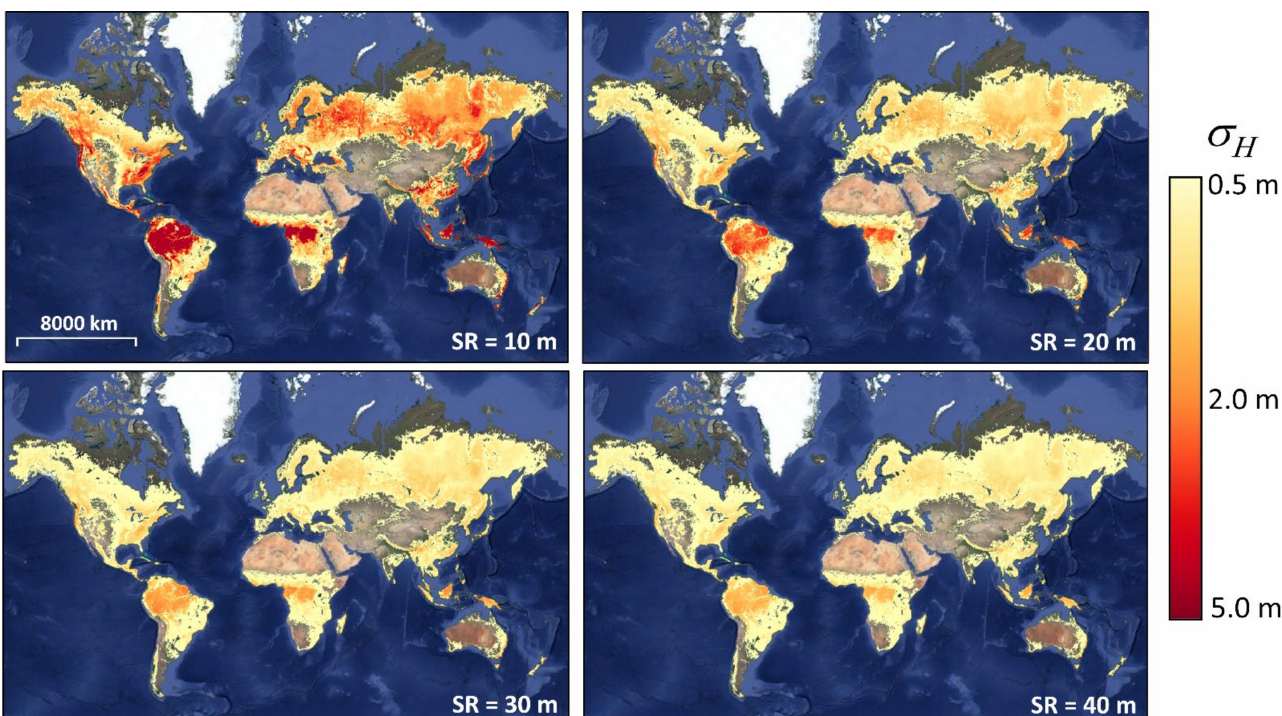
Figure 8. σ H ( x , y ) maps at global scale computed in GEE. Four operative scenarios were proposed by assuming SR at 10m, 20 m, 30 m, 40 m respectively.